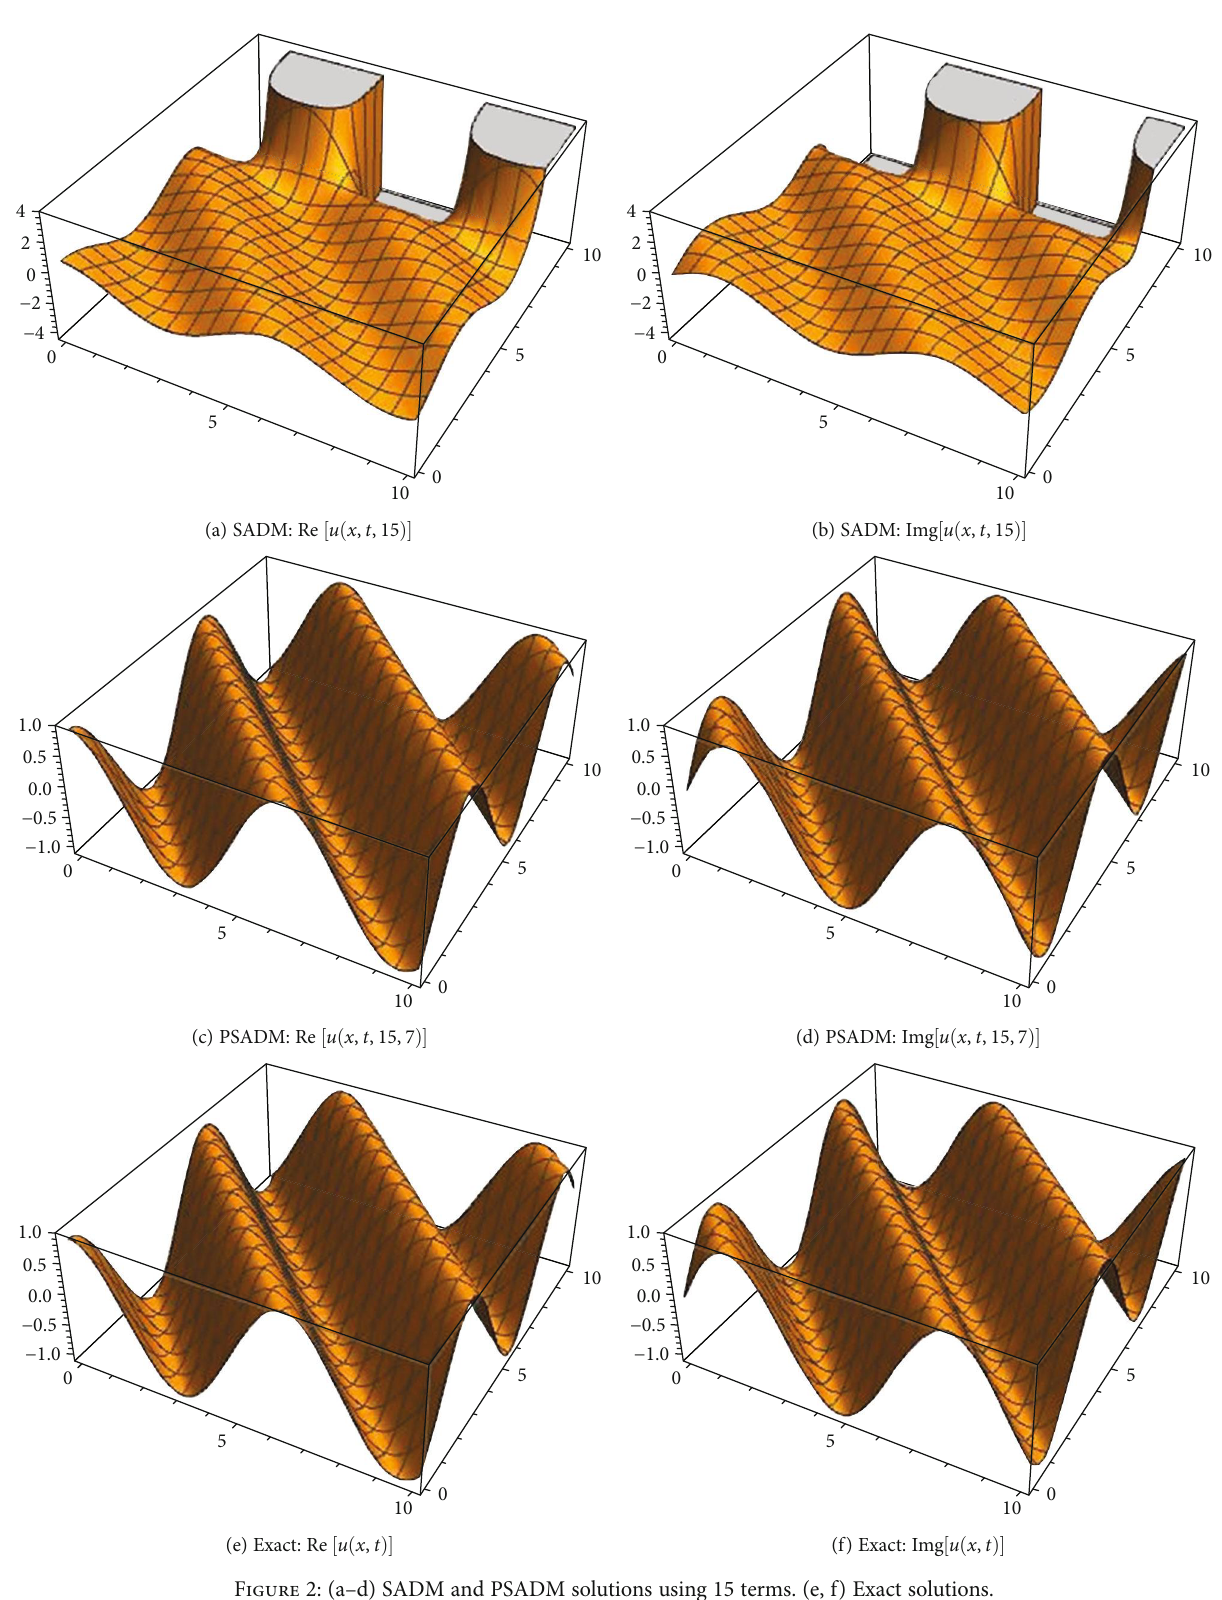
Figure 2: (a – d) SADM and PSADM solutions using 15 terms. (e, f) Exact